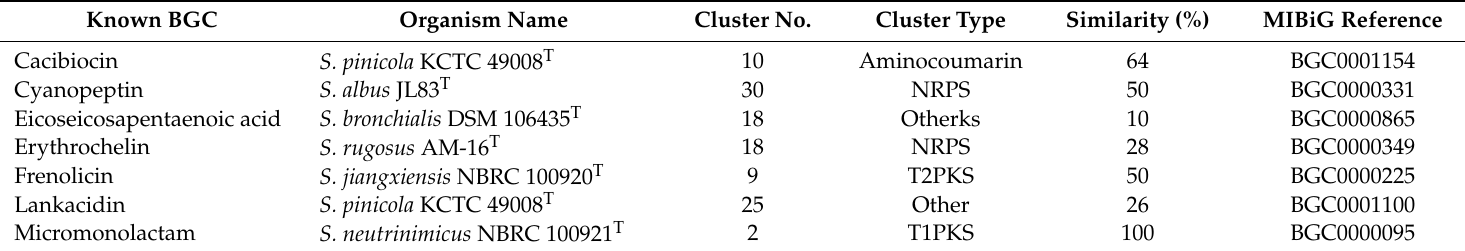
Table 3. List of known BGCs observed only in Streptacidiphilus genomes.